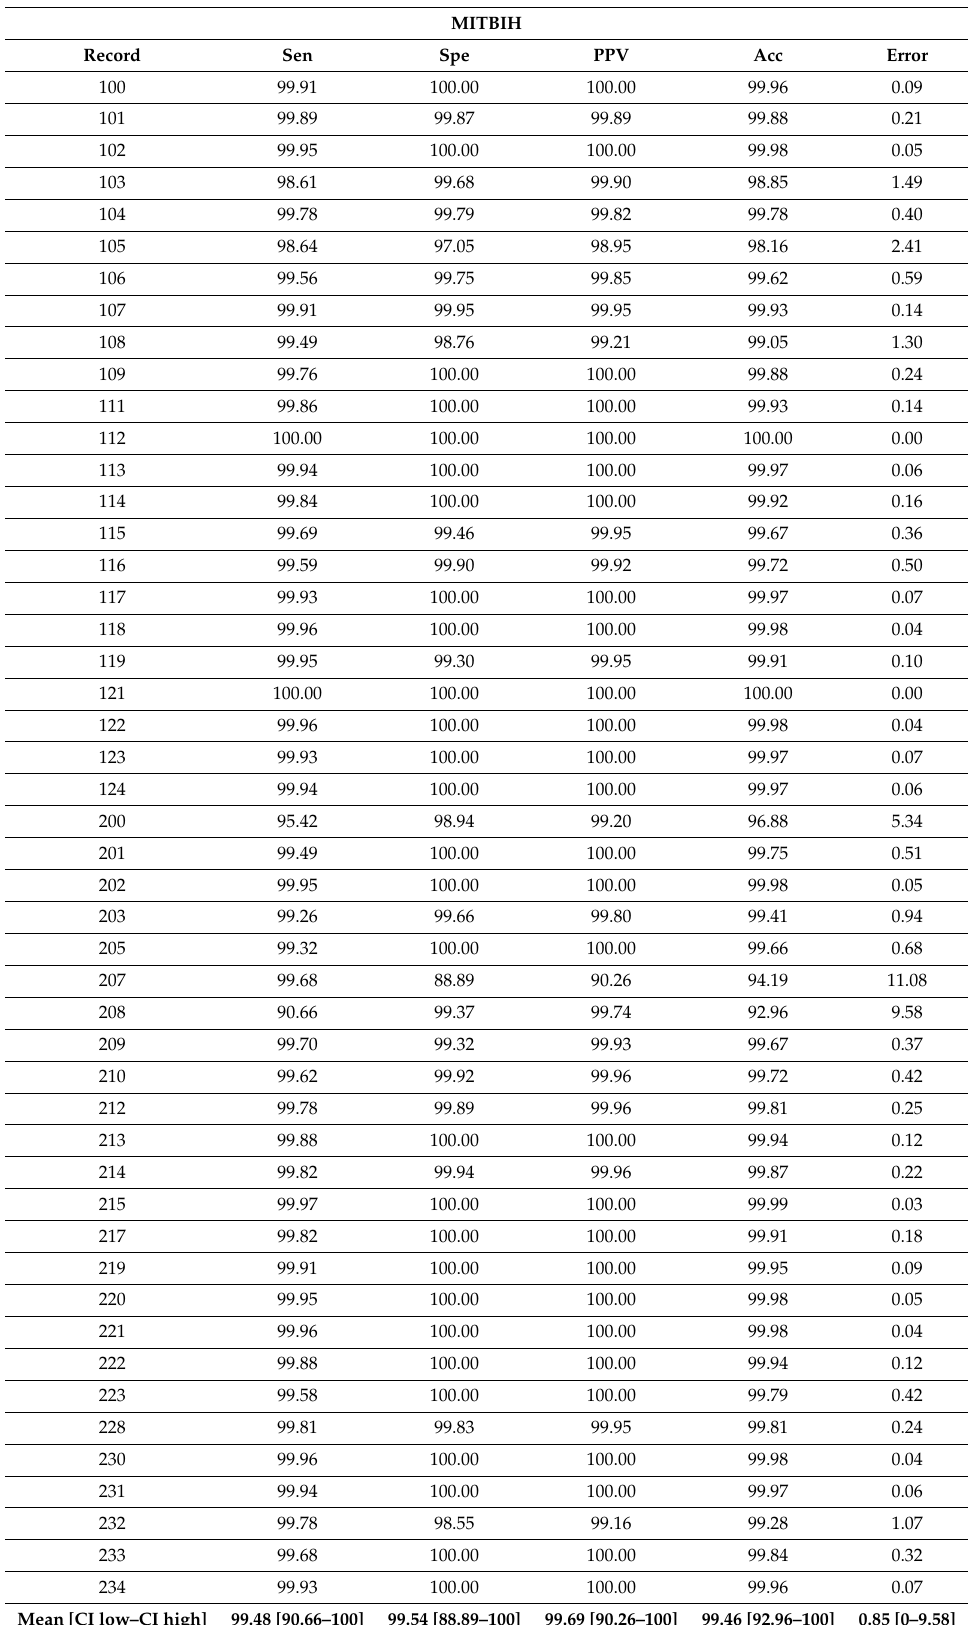
Table 6. Results of the transversal-optimized algorithm using the complete MIT–BIH.